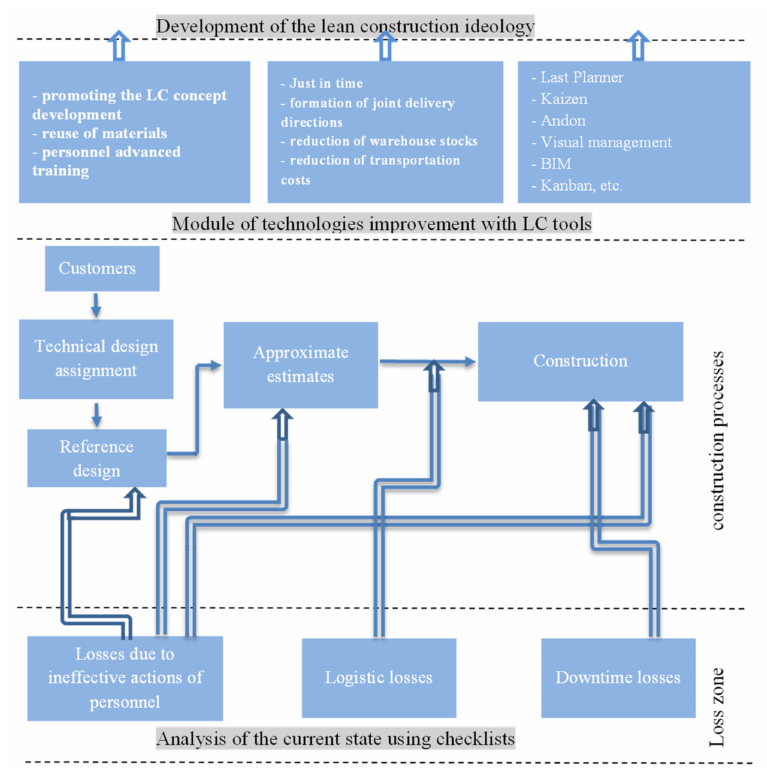
Figure 2. Lean construction implementation